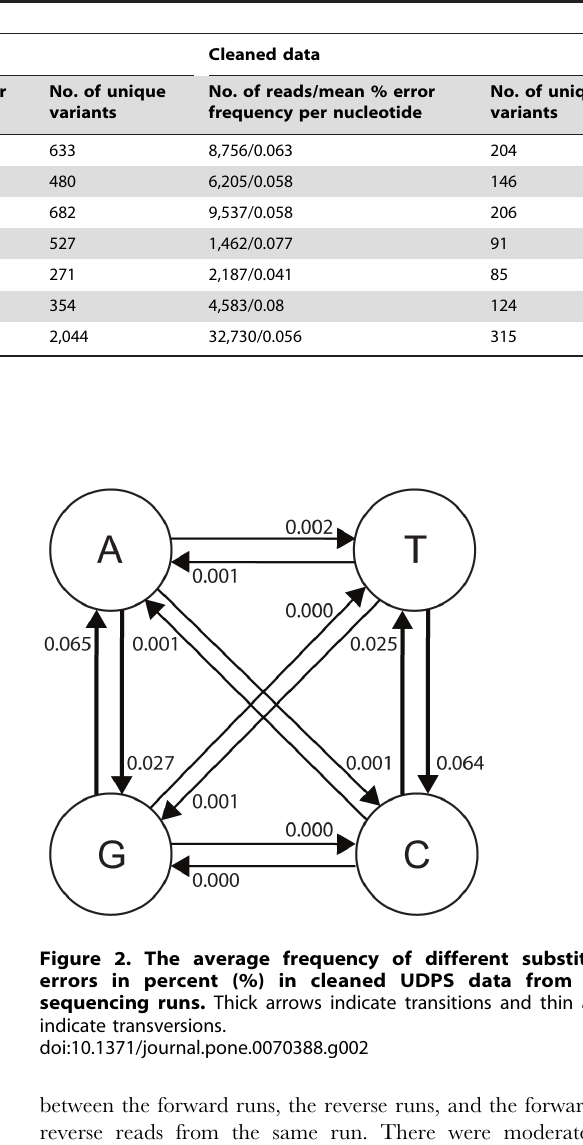
Table 1. Total number of reads and mean error frequency percent (%) per nucleotide as well as the number of unique sequence variants in raw and cleaned UDPS data from forward and reverse reads from three UDPS runs.